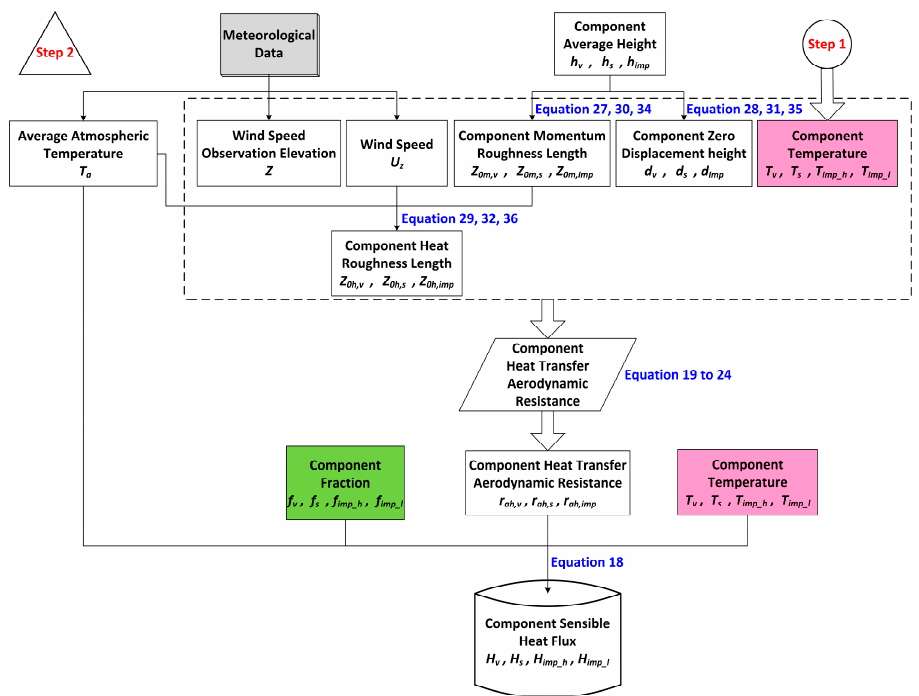
Figure 10. Flowchart of the second step (Step 2) of our model.